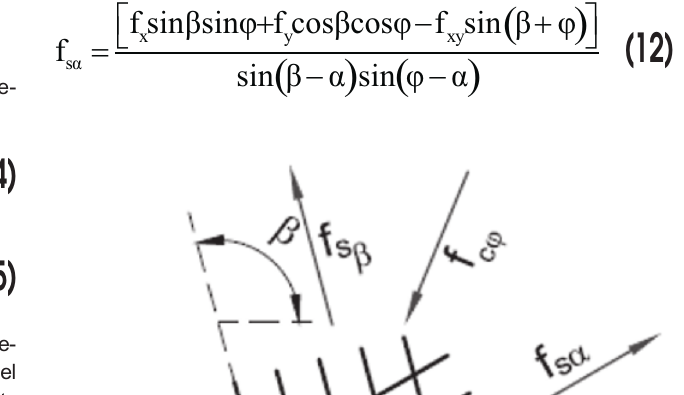
Panel internal forces per unit length